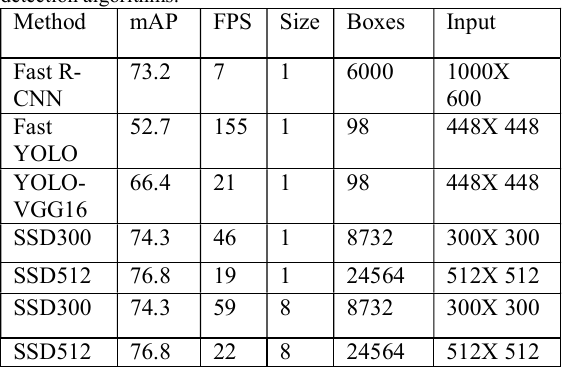
Fig 2 Comparison between face detection algorithms w.r.t